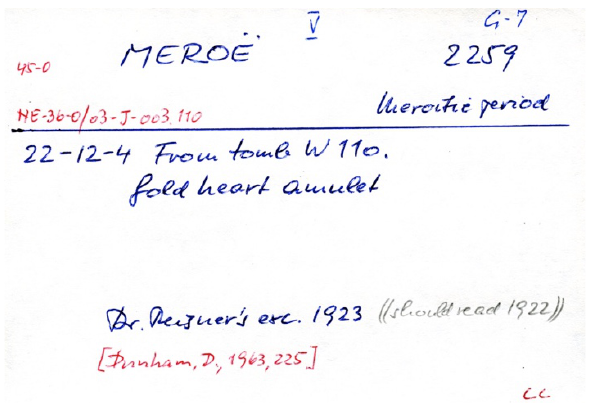
Figure 3. Example of an index card of the registry of the Sudan National Museum copied by Friedrich Hinkel with the addition of its alphanumeric site number.